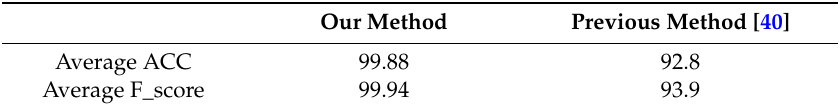
Table 6. Comparisons of accuracies of recognition of arrow marking by our method with previous method (unit: %).